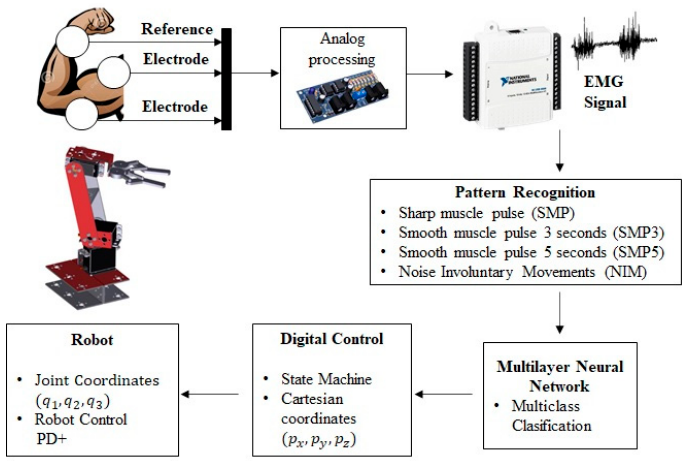
Figure 9. Architecture of the EMG signal classification method for the control of a manipulator robot.